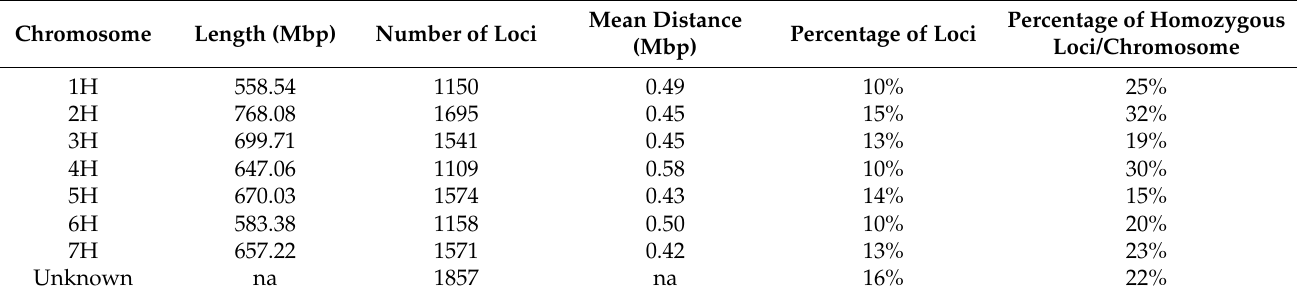
Table 1. Summary of DArTseq loci distribution on chromosomes for 83 spring barley cultivars. Chromosome lengths according to barley Morex genome assembly [21].